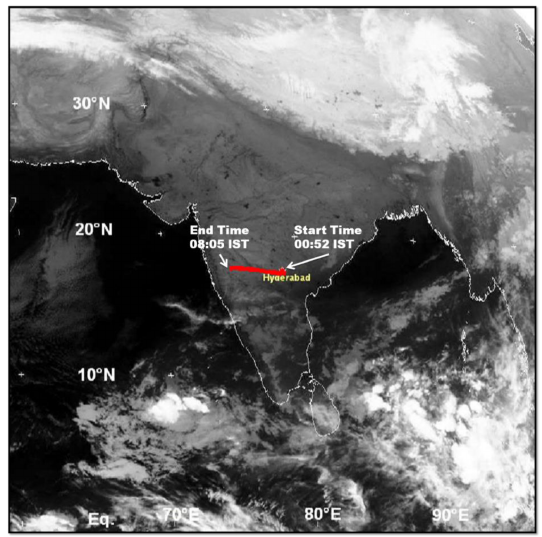
Figure 6. A thermal infrared image (10.5–12.5mm) obtained from the EUMETSAT’s fleet of satellites at 02:30IST on 14 Decem- ber 2013. The balloon track is indicated in red.